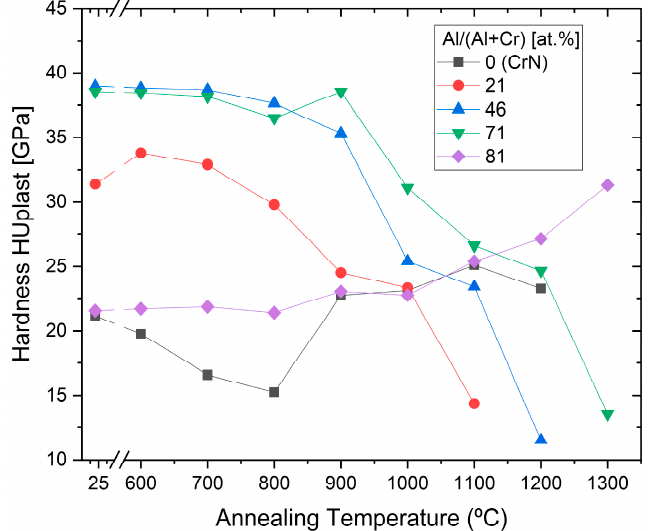
Figure 11. Microhardness for (CrAl)N, (AlCr)N, CrN and AlN coatings after annealing at different temperatures, redrawn after [61], original ©